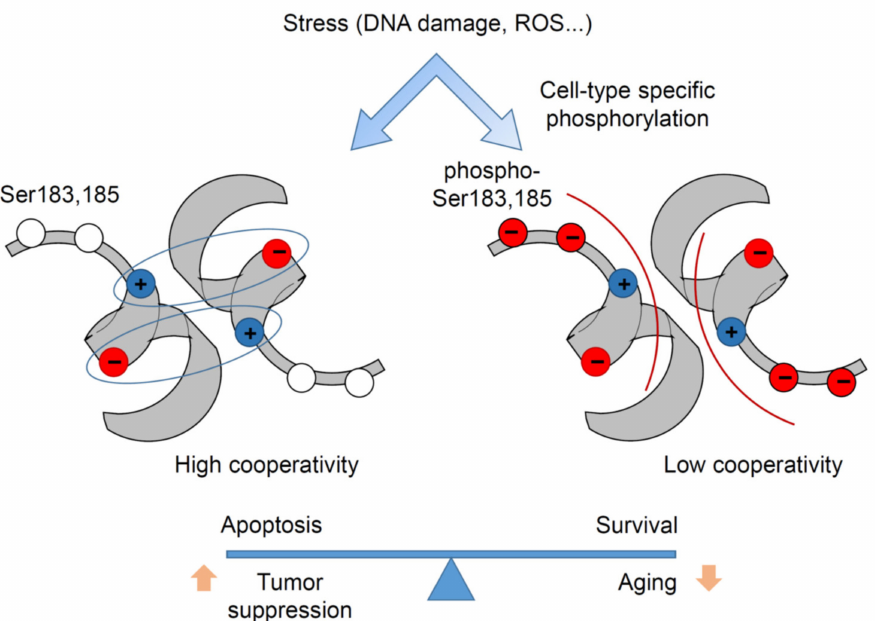
Figure 5. Regulation of DNA binding cooperativity via serine phosphorylation. Left—In the absence of Ser183, Ser185 phosphorylation double salt bridges between Glu180 (red) and Arg181 (blue) of antiparallel H1 helices (schematically shown in gray) determine strong cooperativity, which allows p53 to execute a full-blown response to stress (e.g., DNA damage and ROS) and to effectively suppress tumorigenesis. Right—Upon phosphorylation of Ser183, Ser185 ionic bonds are weakened, leading to reduced cooperativity. This shifts p53 activity toward pro-survival programs (cell cycle arrest, senescence), prevents excessive cell death of stem cells, and protects against premature